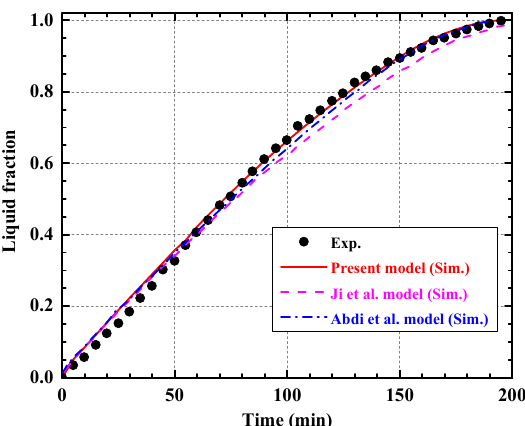
Figure 3. Comparisons among the experiment carried out by Kamkari et al. [45], the present model, Ji et al. model [22] and Abdi et al. model [33] for no fin case.